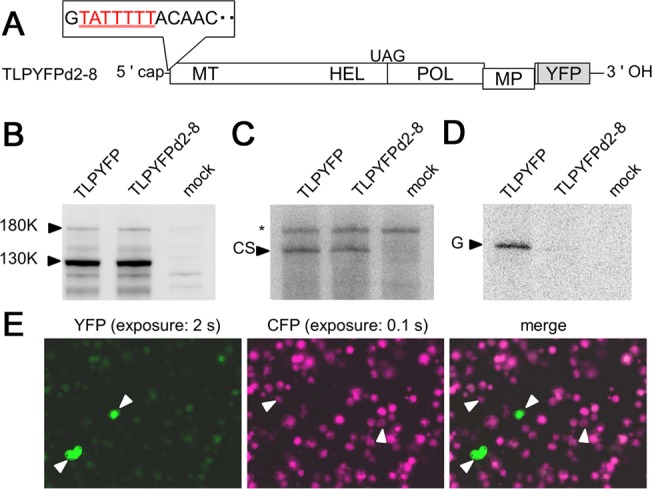
Enhanced variation in progeny accumulation demonstrated experimentally.(A) Structure of TLPYFPd2–8. The deleted region (nt 2–8) is shown by underlined red letters. (B–D) Characterization of TLPYFPd2–8 using an in vitro translation–replication system. (B) Western blotting of the translation products of TLPYFPd2–8 and parental TLPYFP without the 5′-UTR mutation. Arrowheads indicate the positions of the two replication proteins synthesized by translation: 130K and its stop codon read-through product 180K. (C) RNase protection assay (RPA) to detect complementary-strand RNA. An arrowhead indicates the position of the protected RNA originating from complementary-strand RNA (CS). An asterisk indicates the position of an unintended RNA band that originates from the minor complementary transcripts generated during probe preparation. (D) RPA of genomic RNA. An arrowhead indicates the positions of the protected RNAs originating from the genomic RNA (G). (E) Co-inoculation of TLPYFPd2–8 and TLPCFP. The images were obtained at 40 hpi and processed in the same way as described in Fig. 1. Note that the exposure period differs for the detection of YFP and CFP. Arrowheads indicate singly infected cells.